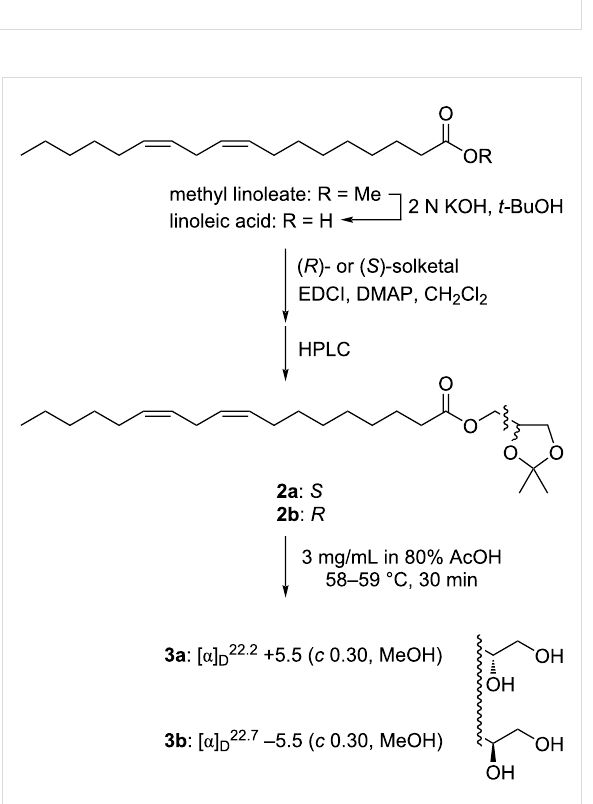
Scheme 1: Synthesis of 1-linoleoyl- sn -glycerol ( 3a ) and 3-linoleoyl- sn - glycerol ( 3b